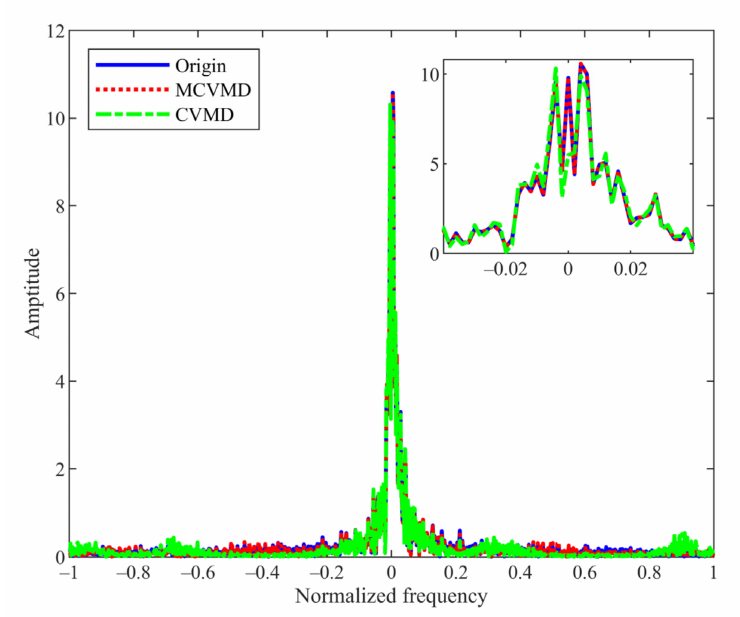
Figure 14. Spectrum of the original wind data (blue solid line), the reconstruction signal of MCVMD results (red dotted line), and the reconstruction signal of CVMD results (green dash-dot